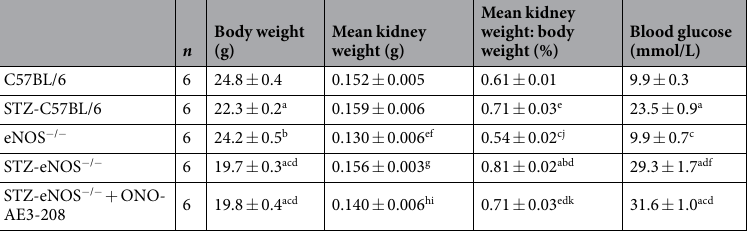
Table 1. Metabolic characteristics of non-diabetic and streptozotocin (STZ)-diabetic wildtype (C57BL/6) and eNOS − / − mice (C57BL/6 genetic background) and STZ-eNOS − / − mice treated with ONO-AE3-208 for three weeks. a p < 0.0001 vs. C57BL/6, b p < 0.01 vs. STZ-C57BL/6, c p < 0.0001 vs. STZ-C57BL/6, d p < 0.0001 vs. eNOS − / − , e p < 0.01 vs. C57BL/6, f p < 0.001 vs. STZ-C57BL/6, g p < 0.01 vs. eNOS − / − , h p < 0.05 vs. STZ-C57BL6,